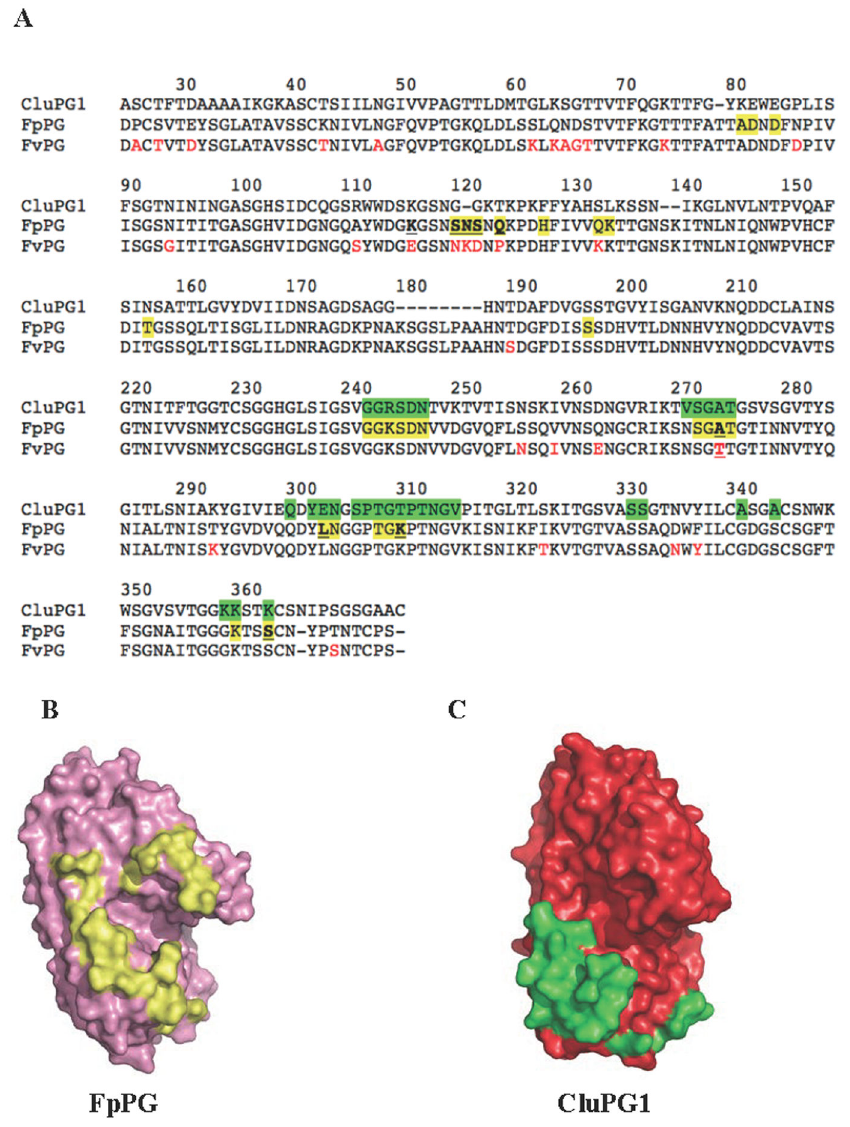
Figure 3. Comparative analysis of the PG amino acids contacted by PvPGIP2. A, Alignment of CluPG1, FpPG and FvPG amino acid sequences. The amino acids belonging to CluPG1 and to FpPG that are contacted by PvPGIP2 are highlighted in green and yellow, respectively. The amino acids belonging to FvPG that differ from the corresponding residues of FpPG are shown in red. Residues subjected to site-directed mutagenesis are underlined. B, Surface representation of FpPG; the amino acids contacted by PvPGIP2 are reported in yellow. C, Surface representation of CluPG1; the amino acids contacted by PvPGIP2 are reported in